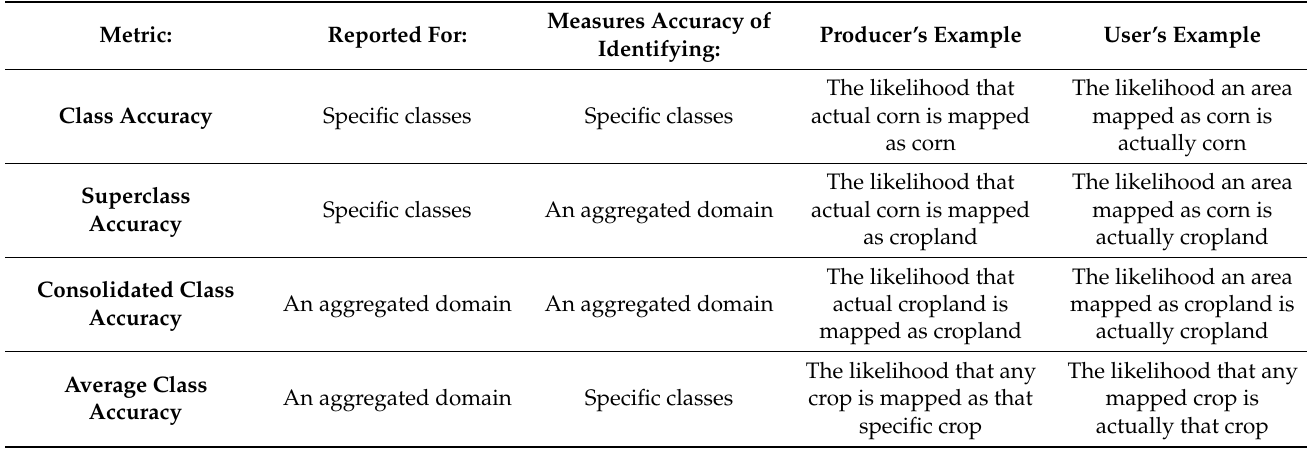
Table 1. Accuracy metrics, measured classes, and associated examples. The table describes each of the four main met- rics reported in this paper and provides an example of each metric from the producer’s accuracy and user’s accuracy